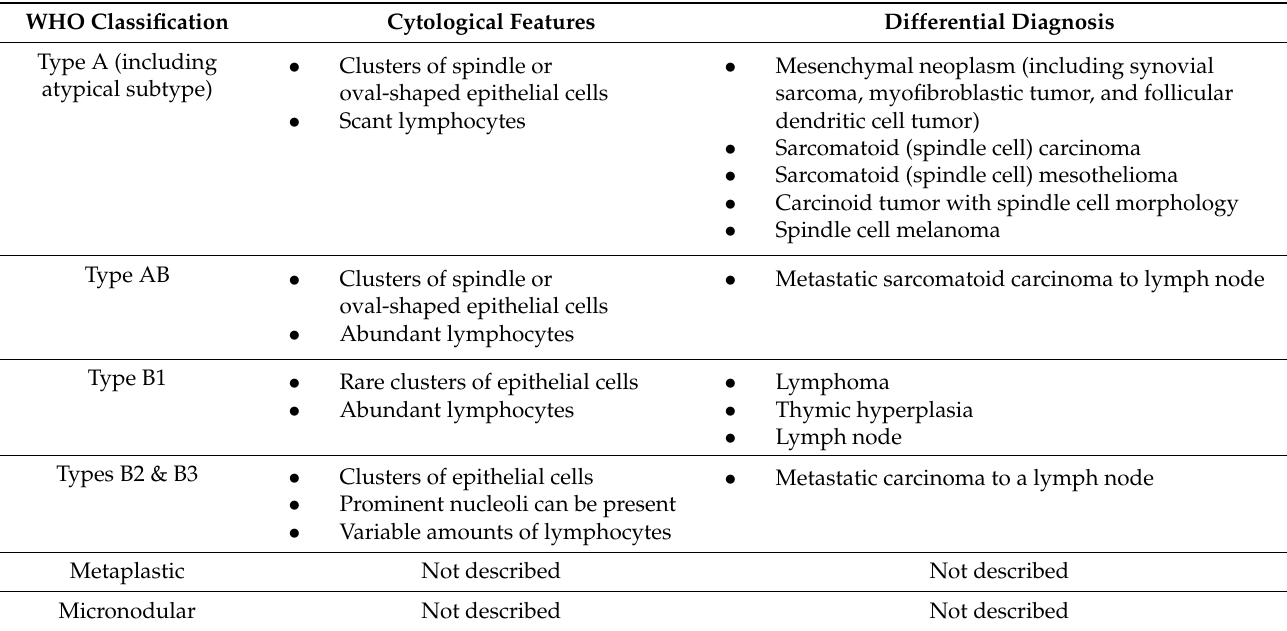
Table 1. Cytological features of thymoma *. Cytological Features Differential